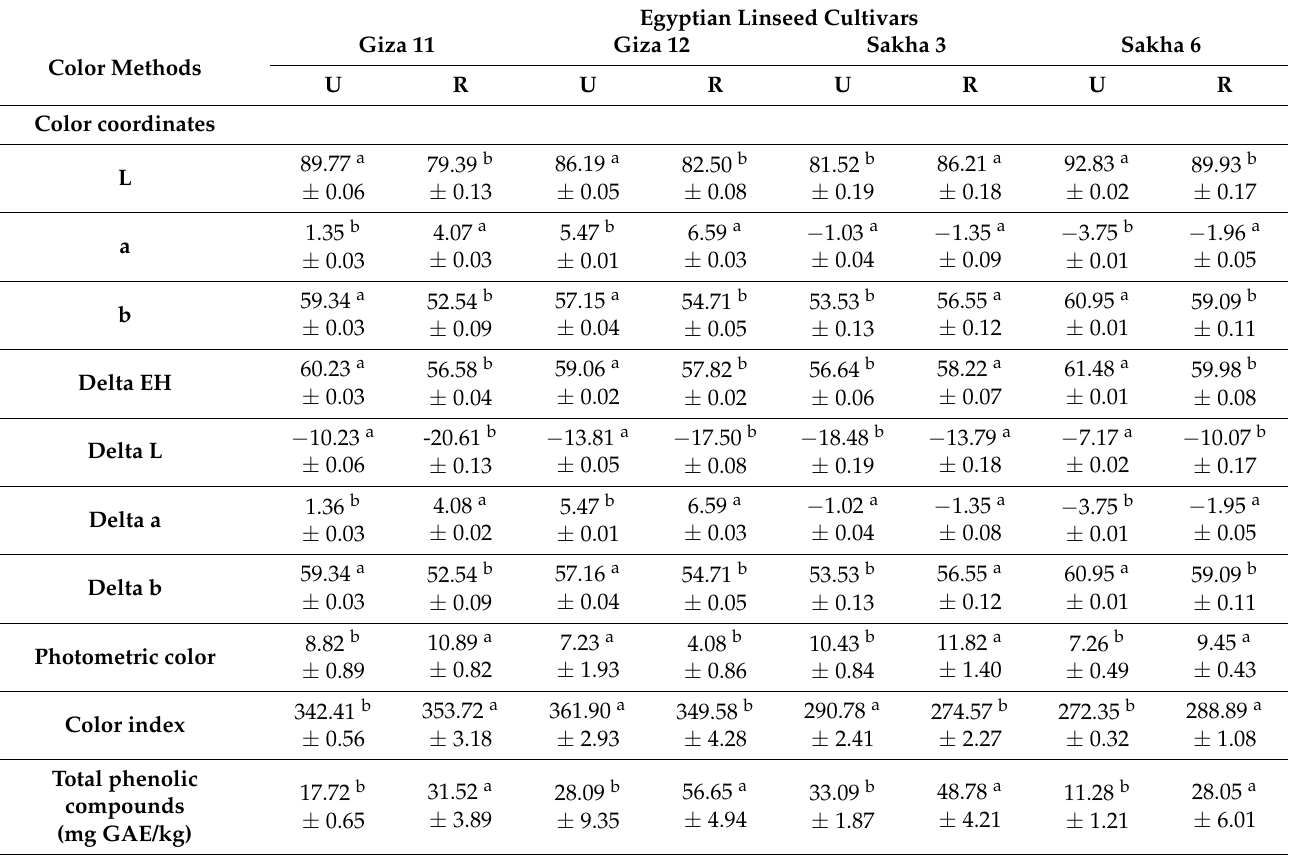
Table 2. Analysis of color by various methods of oil extracted from four Egyptian unroasted and roasted linseed